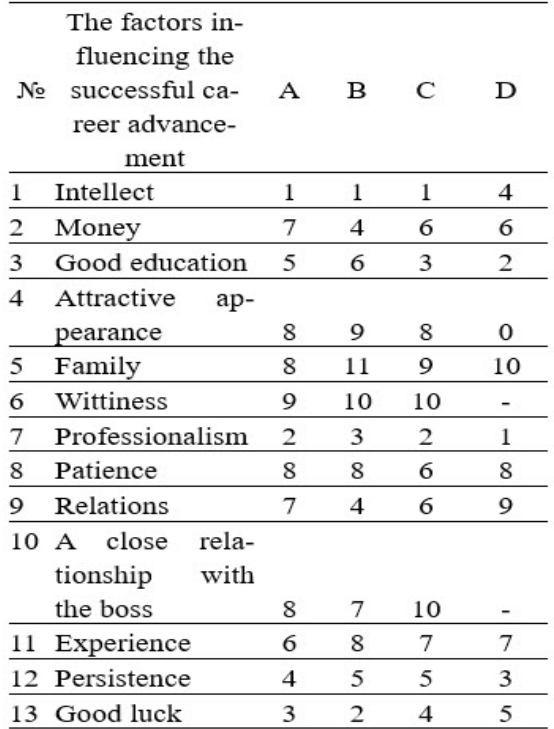
Table 4. The peculiarities of career ori -